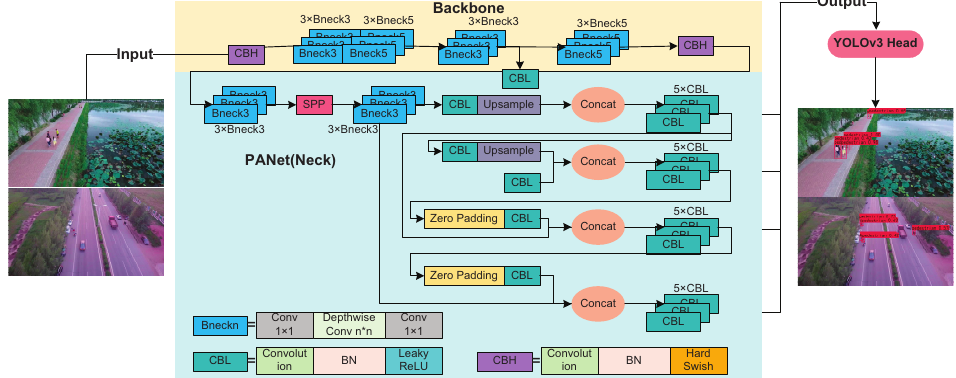
Figure 7. The overall network architecture of the SMYOLO